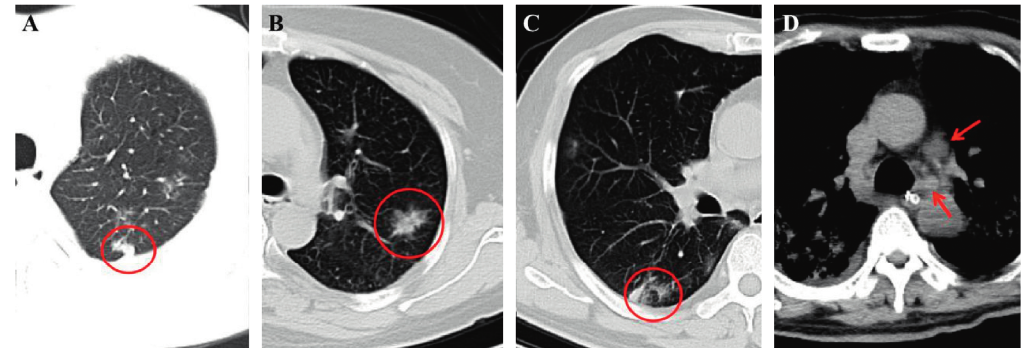
Figure 4: (a) A 46-year-old male COVID-19 patient with fever. CTscan demonstrates a subpleural nodule in the left upper lobe (red circle). (b) A 50-year-old female COVID-19-confirmed patient with dry cough for 4 days. The nontypical halo sign can be seen in the left upper lobe (red circle). (c) The same patient in (a) and the CTdisplays a nontypical reversed halo sign in the right lower lobe (red circle) in the follow-up CT image. (d) A 60-year-old male COVID-19 patient with initial symptoms of dry cough and fever for 3 days. CTscan shows the enlarged lymph nodes in the mediastinum (red arrows), and this patient is diagnosed coinfection with other